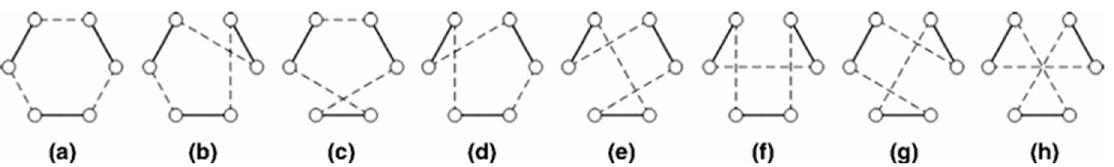
Figure 1. 3 ‐ Opt possible combinations. Figure 1. 3-Opt possible